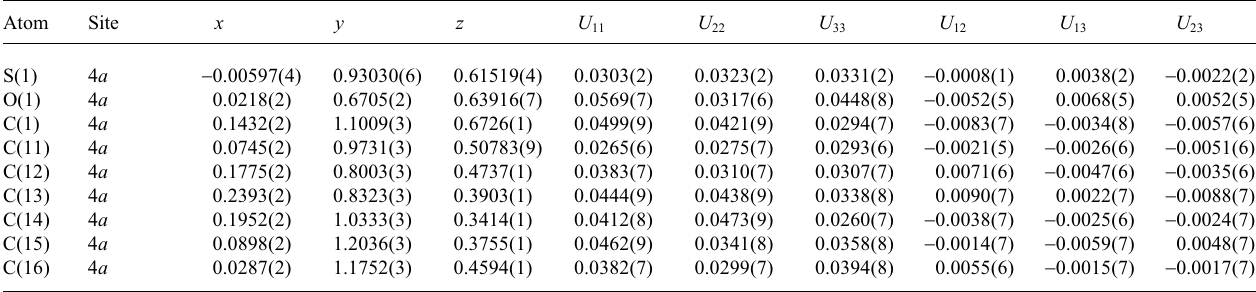
Table 3. Atomic coordinates and displacement parameters (in Å 2 )